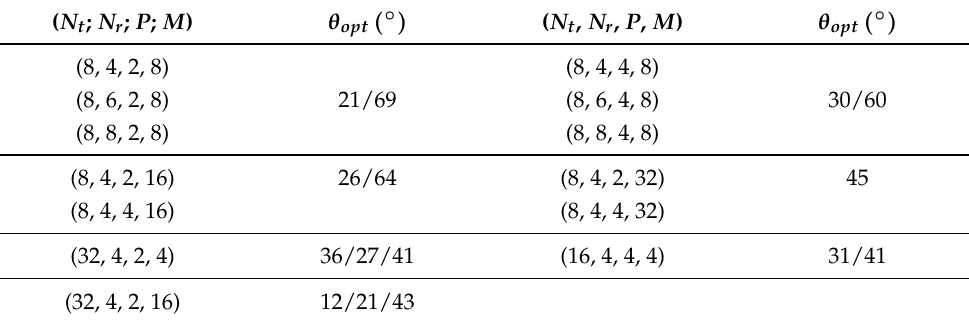
Table 1. Optimal rotation angle, θ opt , for several PCQSM system configurations.